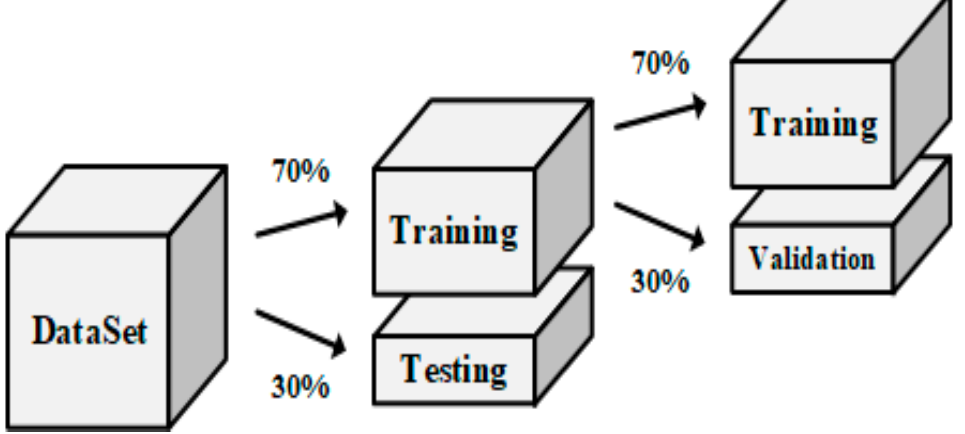
Figure 6. Separate data with training and testing datasets.